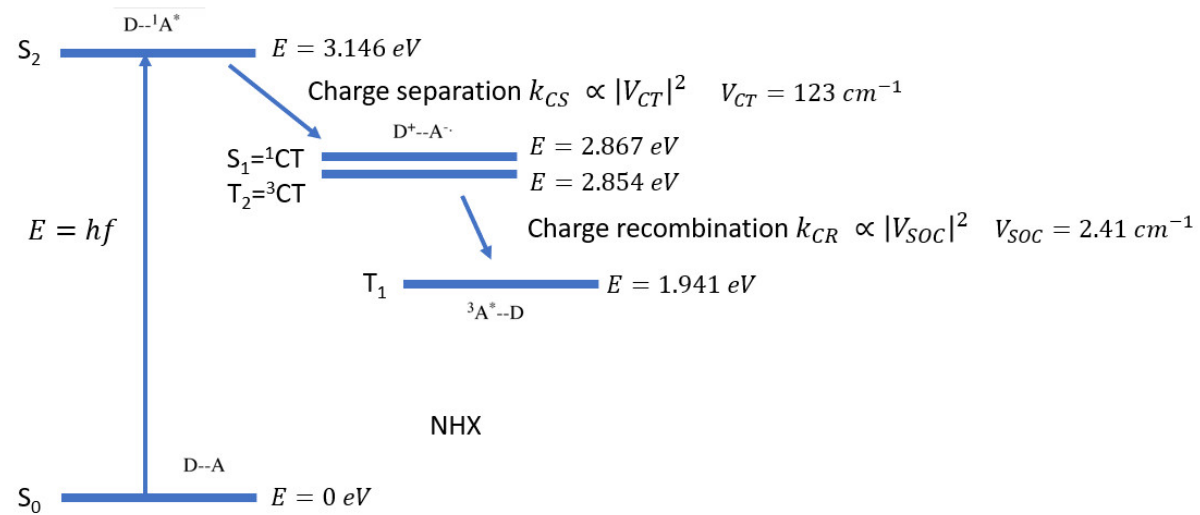
Figure 14. Energies of the excited states, as well as the electronic coupling, and spin–orbit coupling of PyrDMA in n-hexane solvent (NHX), as determined with ADF. The excited state energies are calculated with the TZP basis and PBE functional at the S 1 geometry, which in return is calculated with the TZ2P basis and PBE functional.